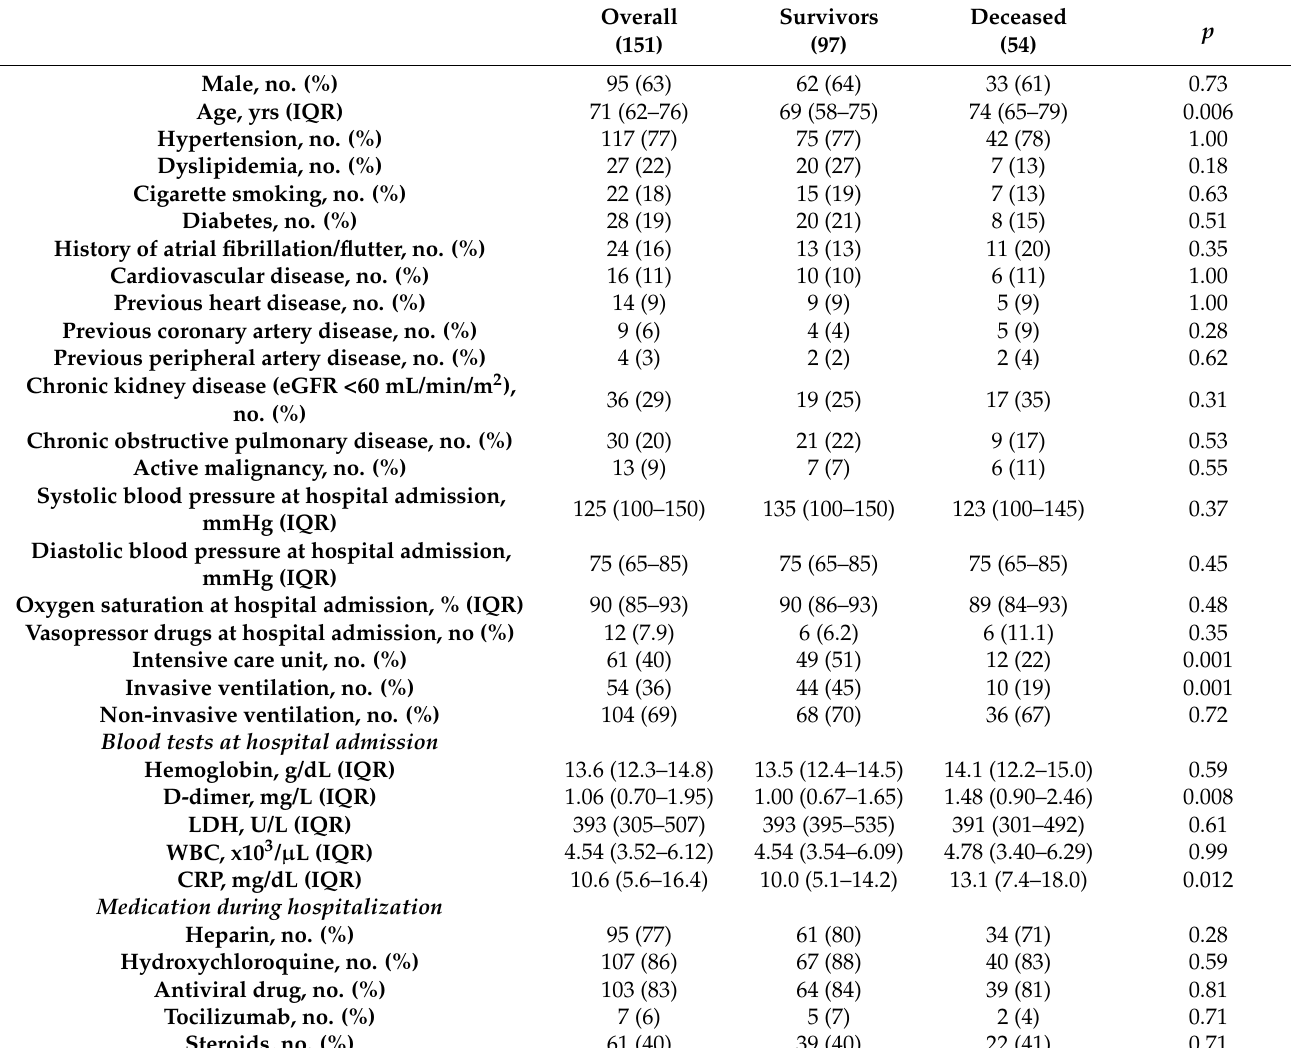
Table 1. Demographic and clinical characteristics, blood tests at hospital admission, and medication during